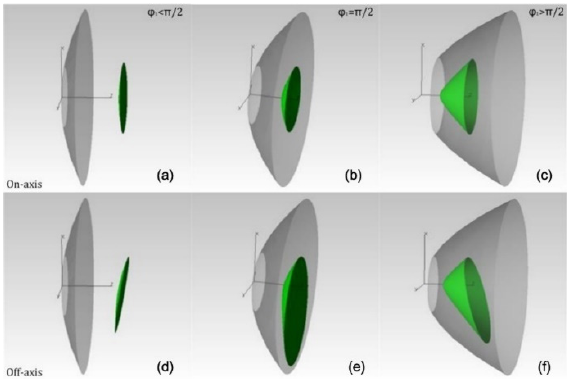
Figure 2. 3D models of three representative geometries correspond to on/off-axis conditions, respectively. On-axis: ( a ) φ 1 < π /2 ( b ) φ 1 = π /2 ( c ) φ 1 > π /2 Off-axis: ( d ) φ 1 < π /2 ( e ) φ 1 = π /2 (f) φ 1 > π /2.